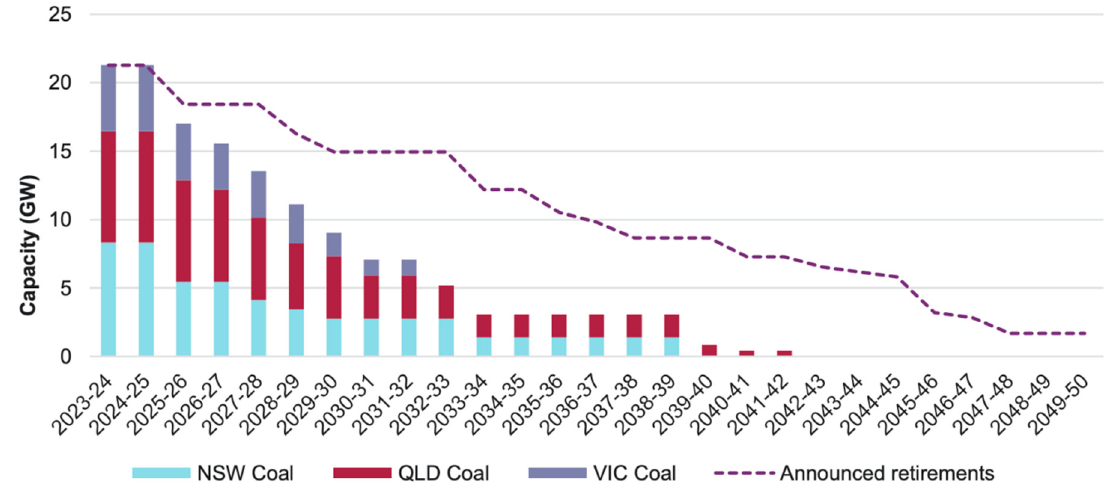
Figure 5. Announced coal retirements contrasted with the 2022 ISP Step Change scenario